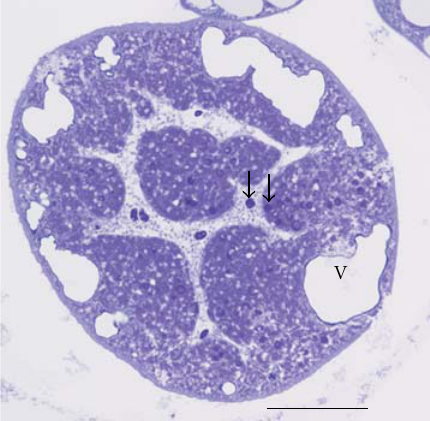
Figure 19: Longitudinal section from the anus of a N. abietis larva showing an innervated (arrowhead) seta (S) extending from the cuticle (C), which is underlain by a single layer of epithelial cells (Ep) and fat body (FB). Posteriorly directed cuticular spines are indicated by the arrows. Scale bar = 60 μ m.